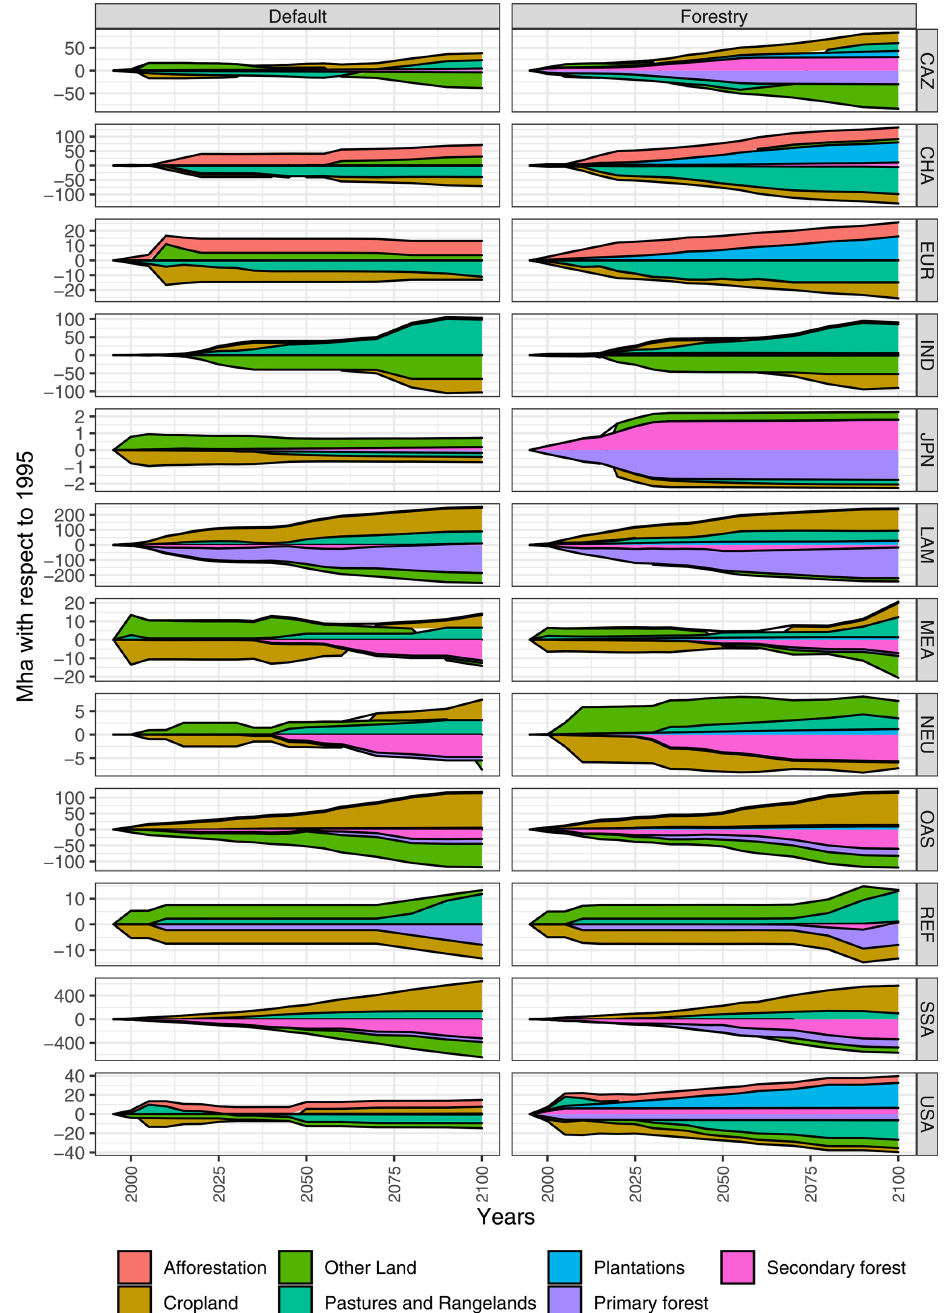
Figure A9. Regional relative land-use change between 1995 and 2100 for the default and forestry scenarios. All values with respect to 1995 (in